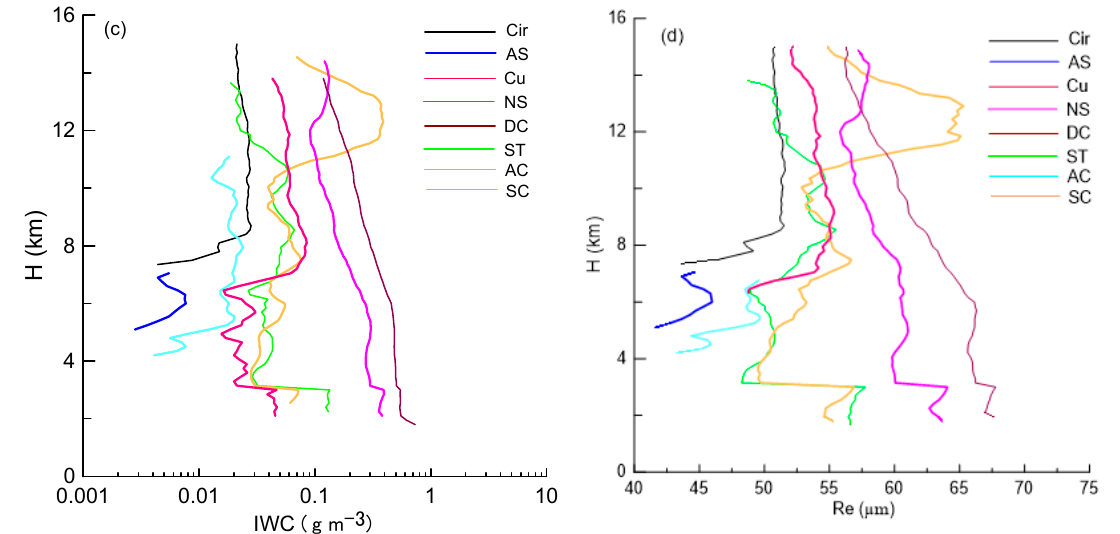
Figure 13. Vertical profiles of ( a ) the averaged reflectivity, ( b ) Vair, ( c ) IWC, and ( d ) Re for eight types of clouds.